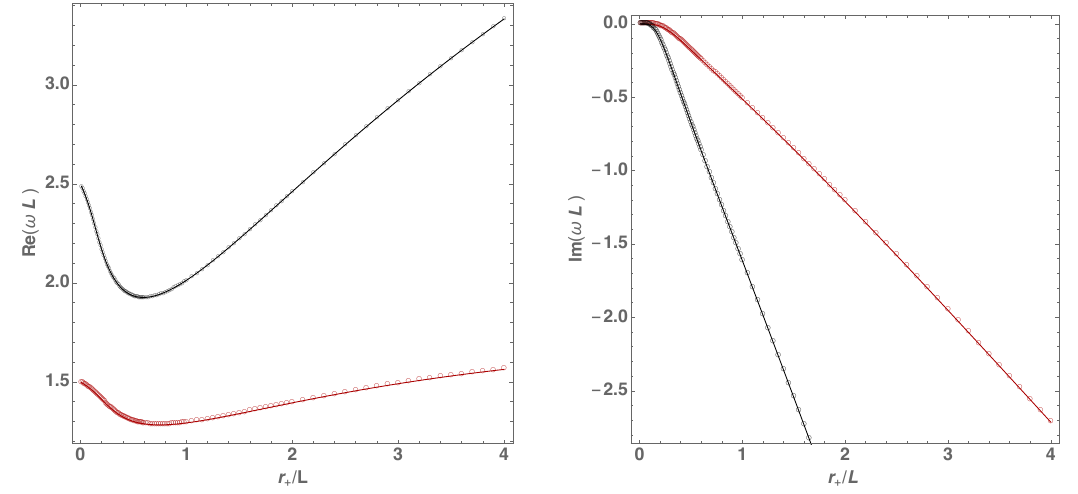
Figure 10 . Real (left) and imaginary (right) part of the QNM frequencies as a function of the horizon radius for the two families of boundary conditions in Schwarzschild-AdS background ( m = 0, ‘ = 1 = 2). The black curve that reduces to the normal mode of AdS !L = 5 = 2 has the standard quantization (2.43) while the red curve (that reduces to the normal mode of AdS !L = 3 = 2) has the alternative quantization (2.44). Not plotted, if we take the black curve data then (cid:0) Re( ! )+ i Im( ! ) is also a solution with alternative quantization (2.44) (which reduces to the AdS normal mode !L = (cid:0) 5 = 2 when the horizon shrinks). Similarly, if we take the red curve data then (cid:0) Re( ! )+ i Im( ! ) is also a solution with standard quantization (2.43).